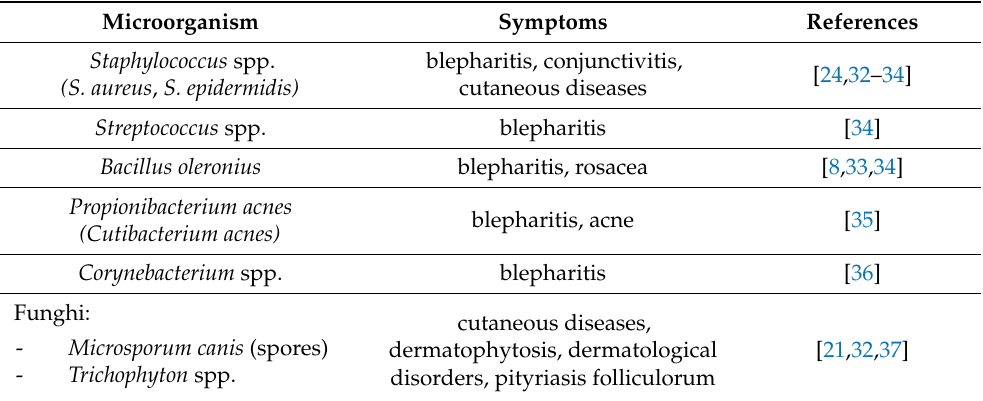
Table 1. Co-infecting organisms associated with